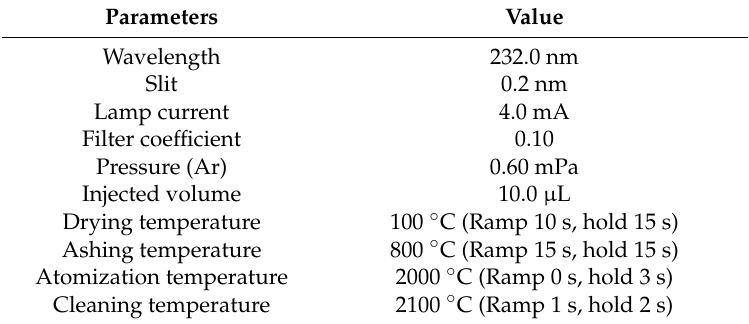
Table 1. Operating conditions for graphite furnace atomic absorption spectrometry